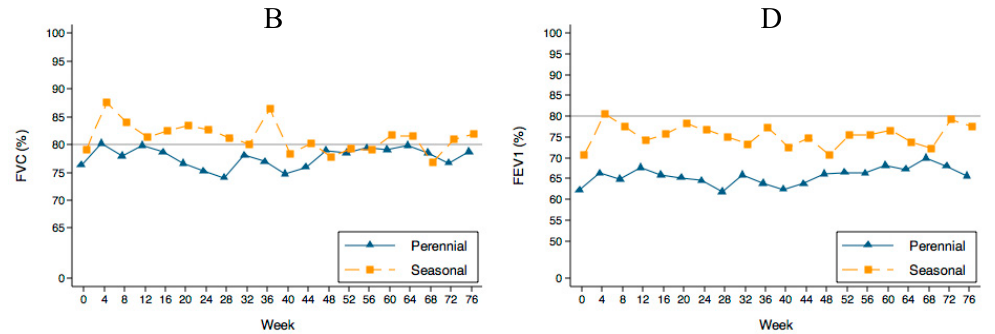
Figure 5. Evolution of the spirometries during follow-up. ( A , C ) show the absolute value in liters (L) and ( B , D ) the percentatge of the predicted value. The lines in ( B , D ) show the normal value. FVC: forced vital capacity. FEV 1 : forced expiratory volume in one second.